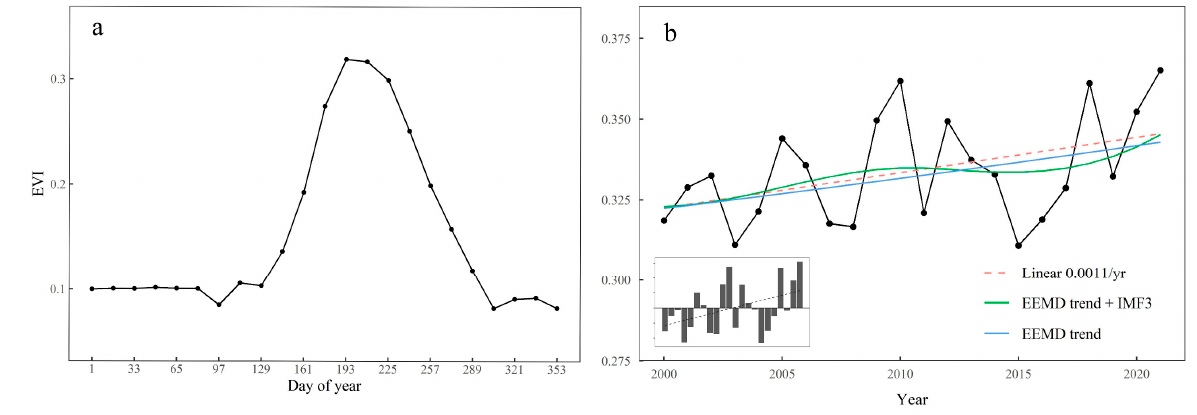
Figure 2. Variations in annual EVI ( a ) and interannual EVI ( b ) during